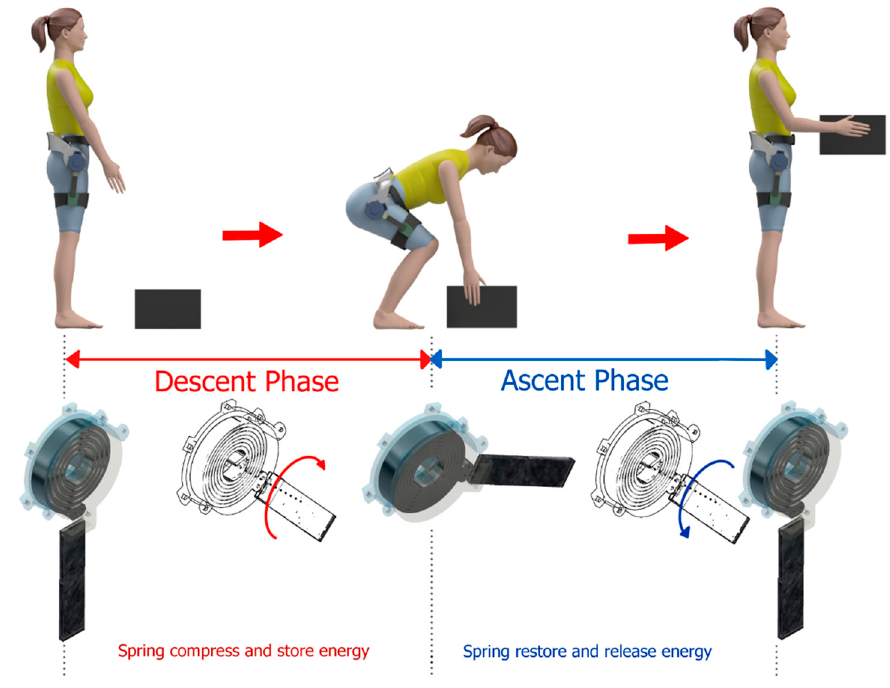
Figure 11. Working principle of the energy storage device .